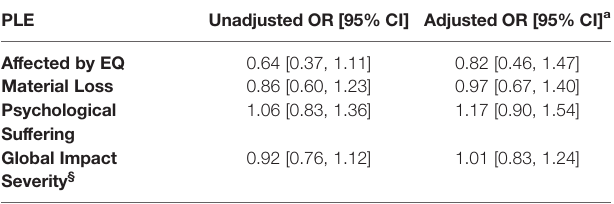
TABLE 3 | Bivariate logistic regression estimates on psychotic-like experiences (PLEs) as dependent variable. PLE Unadjusted OR [95% CI] Adjusted OR [95% CI] a Affected by EQ